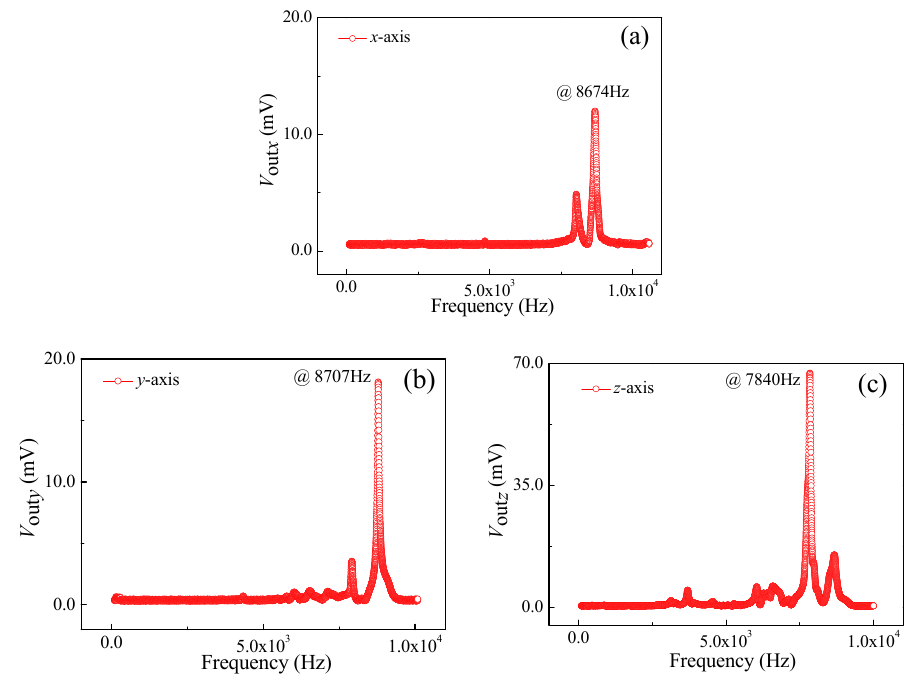
Figure 8. Resonance characteristics of the SOI three-axis acceleration sensor: ( a ) a = a x ; ( b ) a = a y ; and ( c ) a = a z .